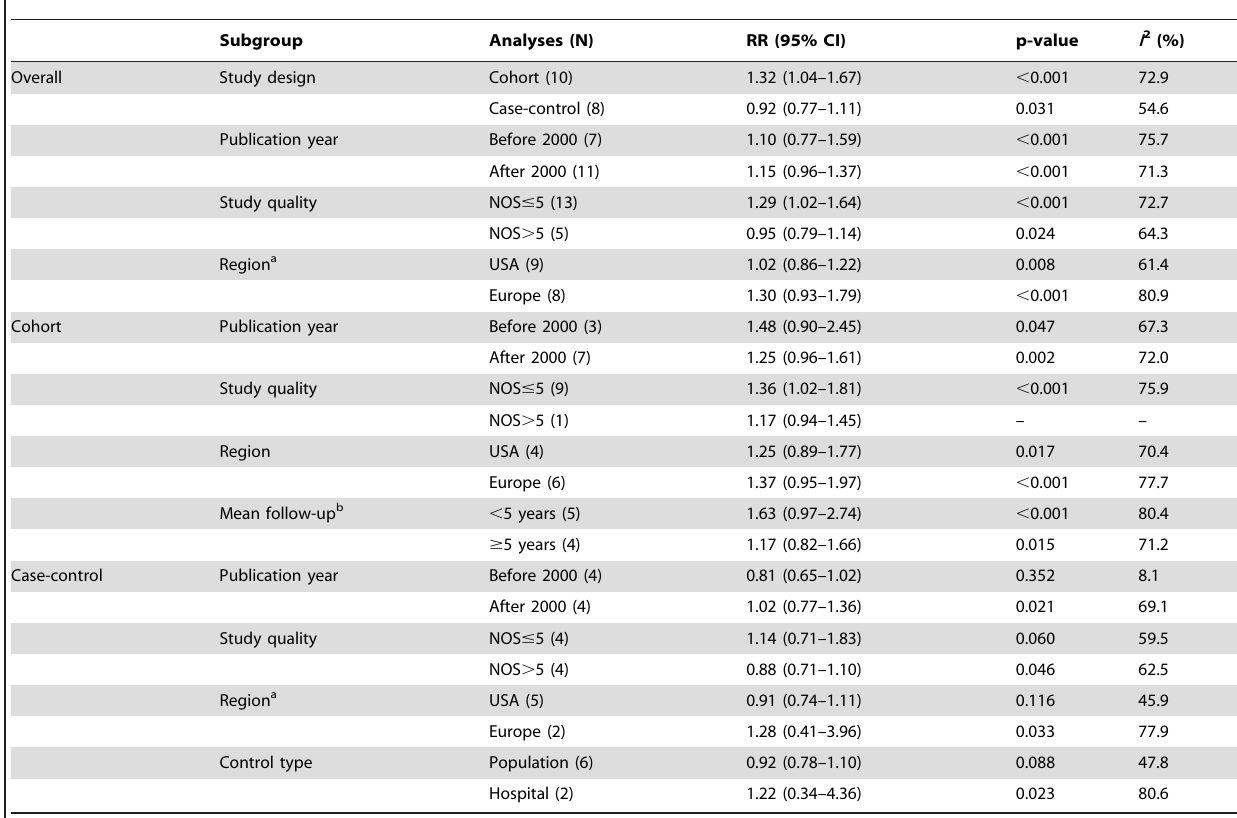
Table 4. Meta-analysis of multiple myeloma incidence by subgroup.